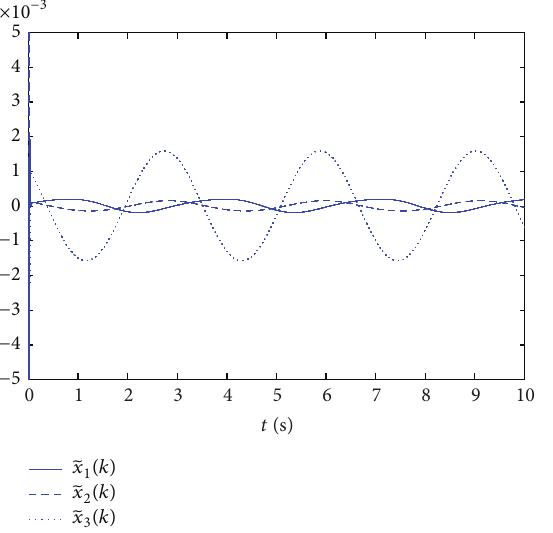
Figure 10: The system state 𝑥 3 (𝑘) .